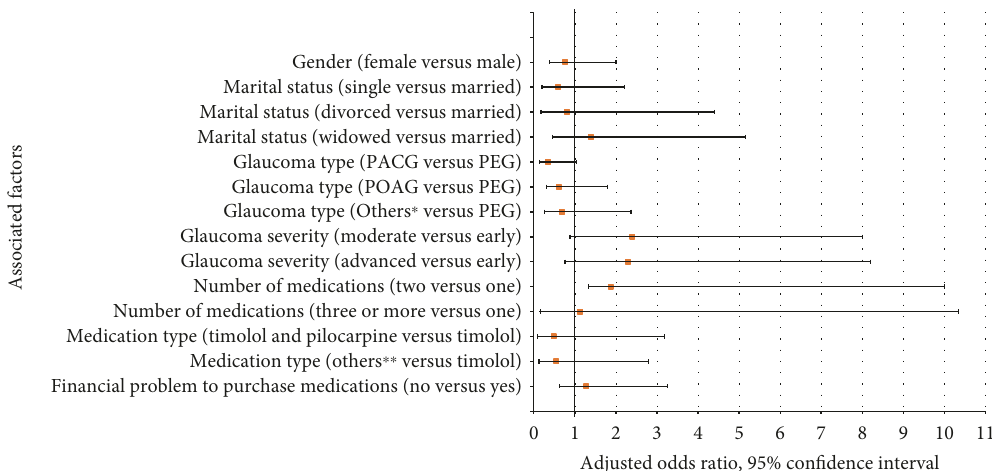
Figure 6: Factors associated with controlled intraocular pressure among patients attending the glaucoma clinic of Menelik II Hospital, 2015. The following factors were used in the logistic regression model: age, sex, marital status, ethnicity, educational level, residence, religion, occupation, monthly family income, type and severity of glaucoma, duration of the glaucoma in years, duration of taking medications in years, average follow-up period per year, the presence of previous surgery or laser treatment, major comorbidities, side e ff ects of medications, acquisition of the medications (free of charge or not), fi nancial problem to purchase the medications, the presence of other types of eye drops, adherence towards the medications, and instillation pro fi ciency of the eye drops. The factors were assumed statistically signi fi cant at p < 0 05 and the end of the bar graph shows the odds ratio. PACG: primary angle-closure glaucoma; PEG: pseudoexfoliative glaucoma; POAG: primary open-angle glaucoma. ∗ Secondary glaucoma, ocular hypertension, normal tension glaucoma, juvenile glaucoma ∗∗ latanoprost; pilocarpine; timolol and latanoprost; timolol with other types of eye drops; pilocarpine with other types of eye drops; latanoprost with other types of eye drops; timolol, latanoprost, and pilocarpine; timolol and latanoprost with other types of eye drops; timolol and pilocarpine with other types of eye